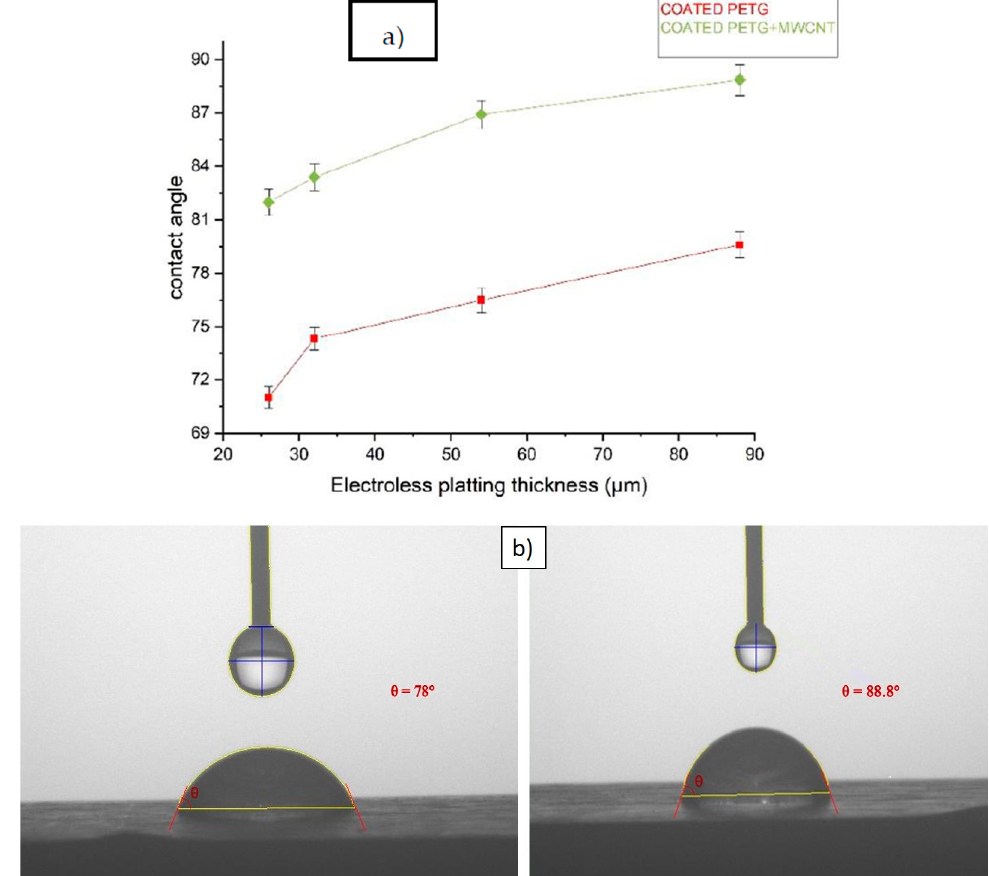
Figure 15. ( a ) The contact angle for various electroless plating thicknesses; ( b ) water droplet con- tacting the specimen’s surface.